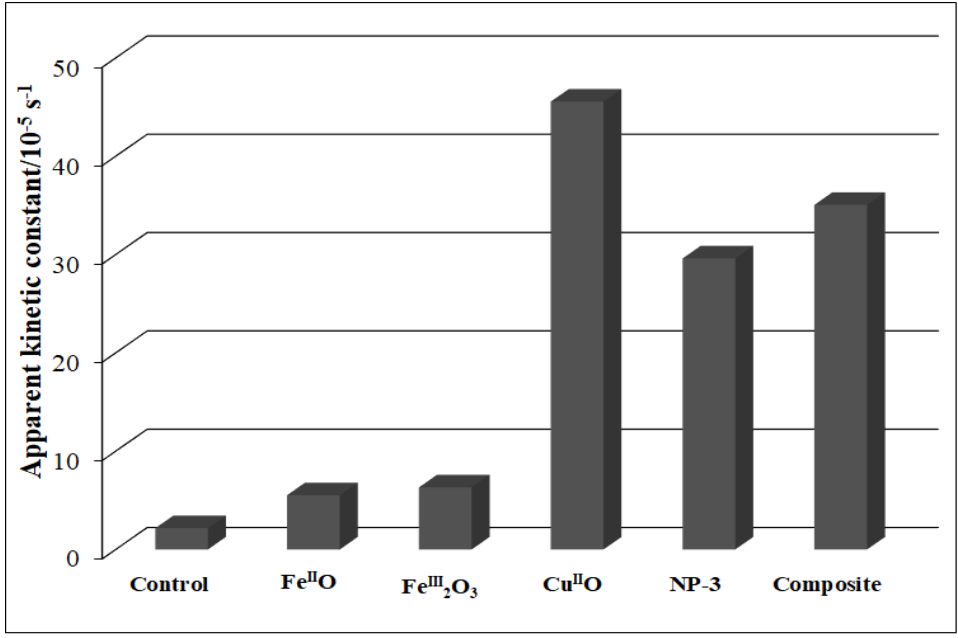
Figure 9. Comparison of apparent kinetic constants of Fe II O, Fe III2 O 3 , Cu II O, NP-3 (Cu II0.4 Fe II0.6 Fe III2 O 4 ), and Cu II O/Fe II O/Fe III2 O 3 composite in the photodegradation of RhB. Experi- mental conditions: concentration of RhB = 1.75 × 10 −5 mol/L, concentration of NPs = 400 mg/L, con- centration of H 2 O 2 = 1.76 × 10 −1 mol/L, and initial pH = 7.5.